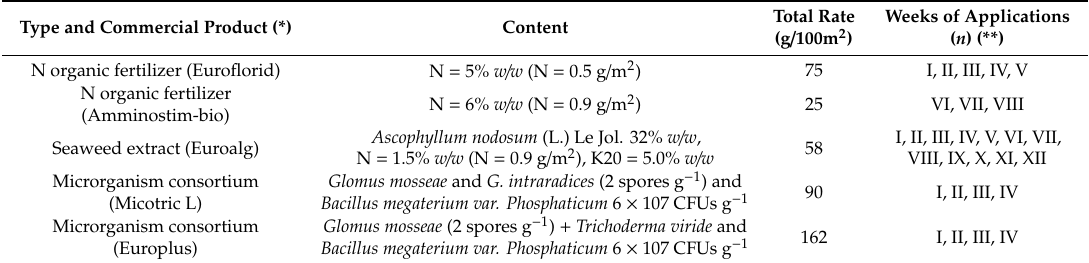
Table 2. Combined use of N organic fertilizer, seaweed extract, and microorganism consortium applied in two experiments (2011 and